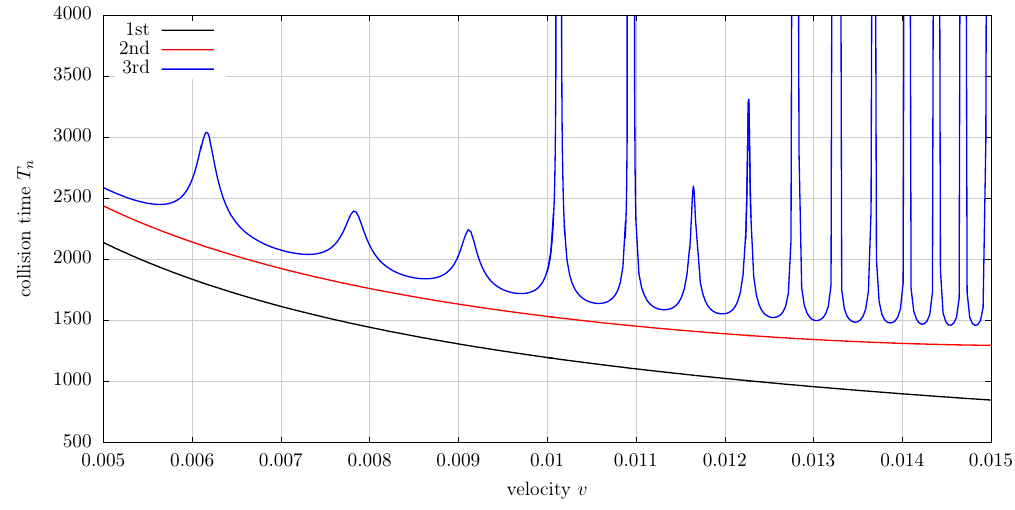
Figure 31 . A closer look at the processes shown in figure 30(a), showing the times to the first, second and third bounces for the scattering of small kinks and antikinks in the (0 , π ) + ( π, 0) configuration at (cid:15) = (cid:15) cr